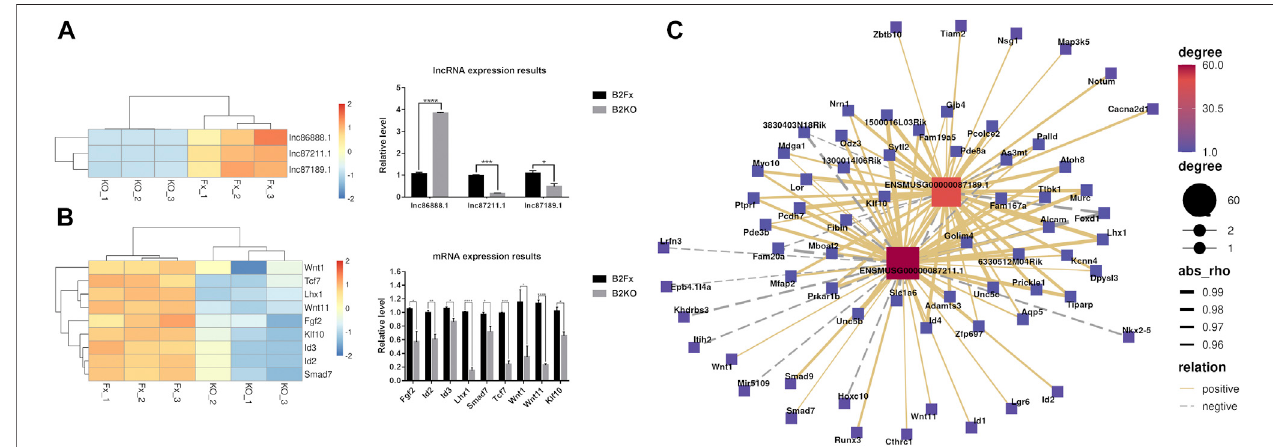
FIGURE 7 | RT-qPCR relative expression results. There are 9 mRNAs and 3 hub lncRNAs validated by RT-qPCR. (A) Results of the RNA-seq and RT-qPCR from the lncRNAs of lncRNA87211.1 (ENSMUSG00000087211.1), lncRNA87189.1 (ENSMUSG00000087189.1), and lncRNA86888.1 (ENSMUSG00000086888.1). (B) Results of the RNA-seq and RT-qPCR from 9 mRNAs including Fgf2 , Id2 , Id3 , Klf10 , Lhx1 , Smad7 , Tcf7 , Wnt1 , and Wnt11 . The red color represents high fold-change, and the blue color represents low fold-change. The abscissa is the gene name, and the ordinate is the relative expression of the genes. (C) Hub co-expression network between two lncRNAs lncRNA87211.1 and lncRNA87189.1 and 6 mRNAs. The solid line shows positive regulation while the dashed line represents negative